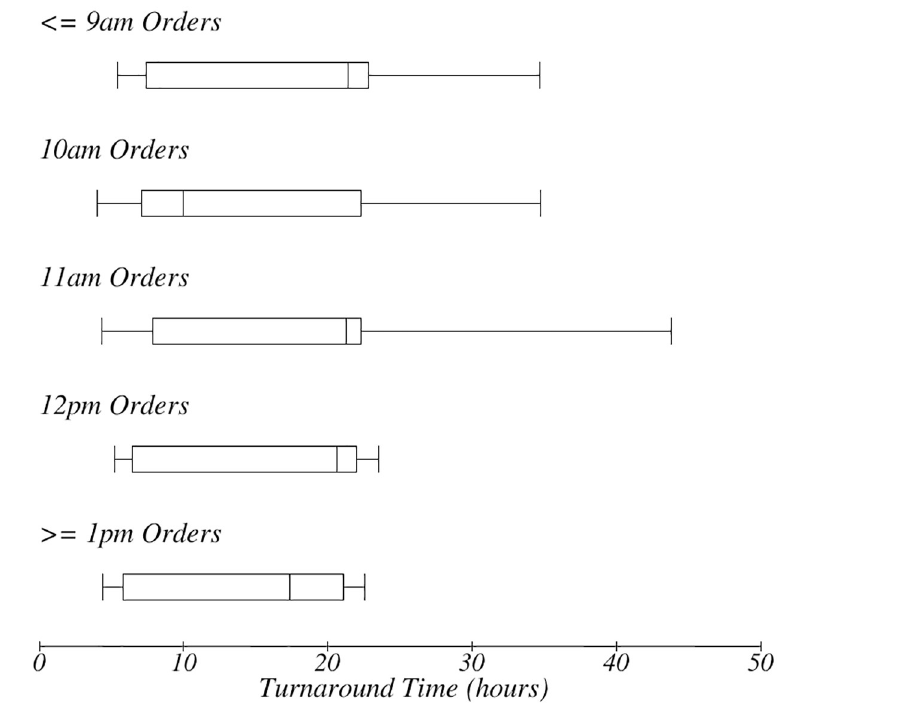
Fig 3. TAT for time of order. The box-plot shows the time the test was ordered and impact on TAT.